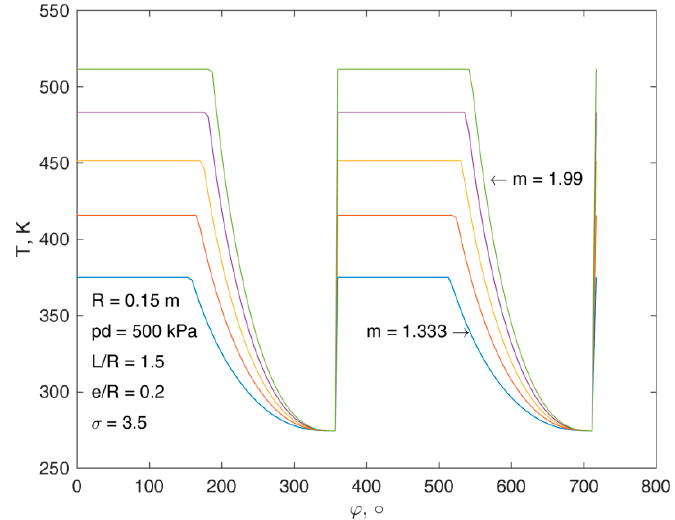
Figure 9. Temperature in a working chamber versus rotor rotation angle for different polytropic exponents ( m ), m = 1.333 (blue line), m = 1.4973 (red line), m = 1.6615 (orange line), m = 1.8258 (violet line), m = 1.99 (green line).